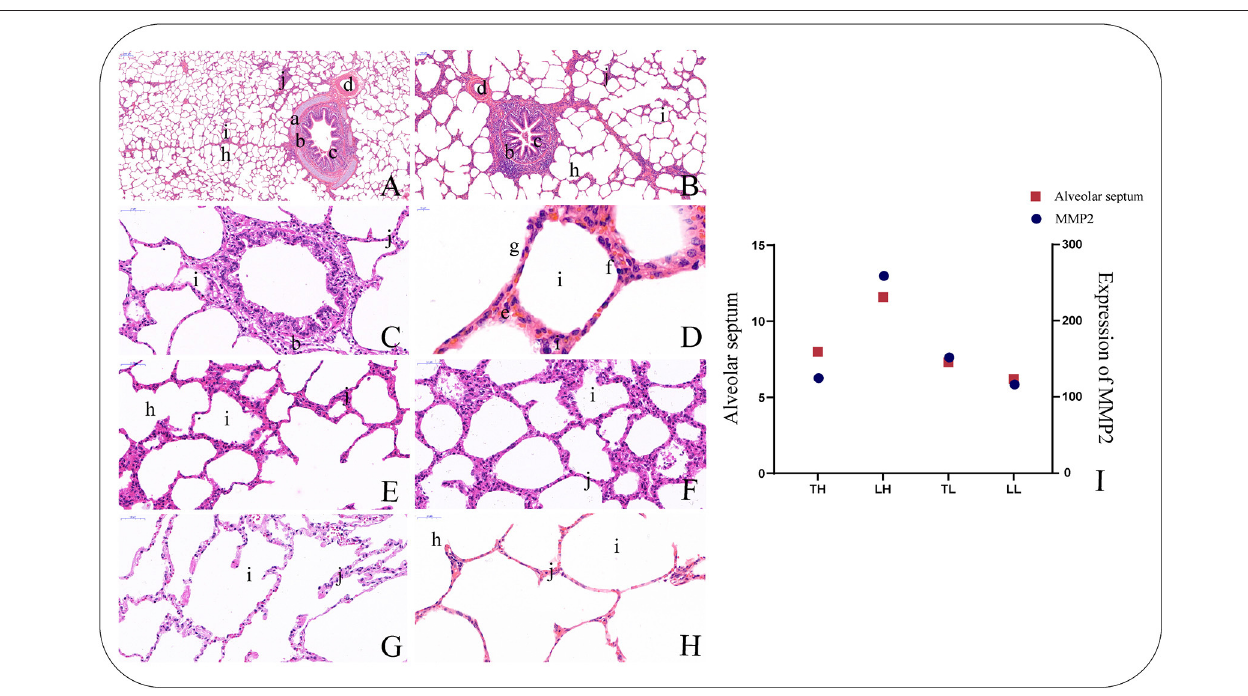
FIGURE 1 | Morphological characteristics of the lungs in Tibetan pigs by H and E staining. (40 × ). (A) Morphological characteristics of small bronchiole. (B) Morphological characteristics of bronchiole. (C) Morphological characteristics of terminal bronchiole. (D) Morphological characteristics of alveolar cells. (E) Morphological characteristics of alveolar septa in the Tibetan pigs raised in highland (TH) group. (F) Morphological characteristics of alveolar septa in the Landrace pigs raised in highland (LH) group. (G) Morphological characteristics of alveolar septa in the Tibetan pigs raised in lowland (TL) group. (H) Morphological characteristics of alveolar septa in the Landrace pigs raised in lowland (LL) group. (I) The histogram shows the expression levels of MMP 2 in the lungs of the four types of pigs and the relationship with alveolar septa. a. Piece of cartilage. b. Smooth muscle. c. Plica. d. Arteriole. f. Alveolar epithelial type II cells. g.